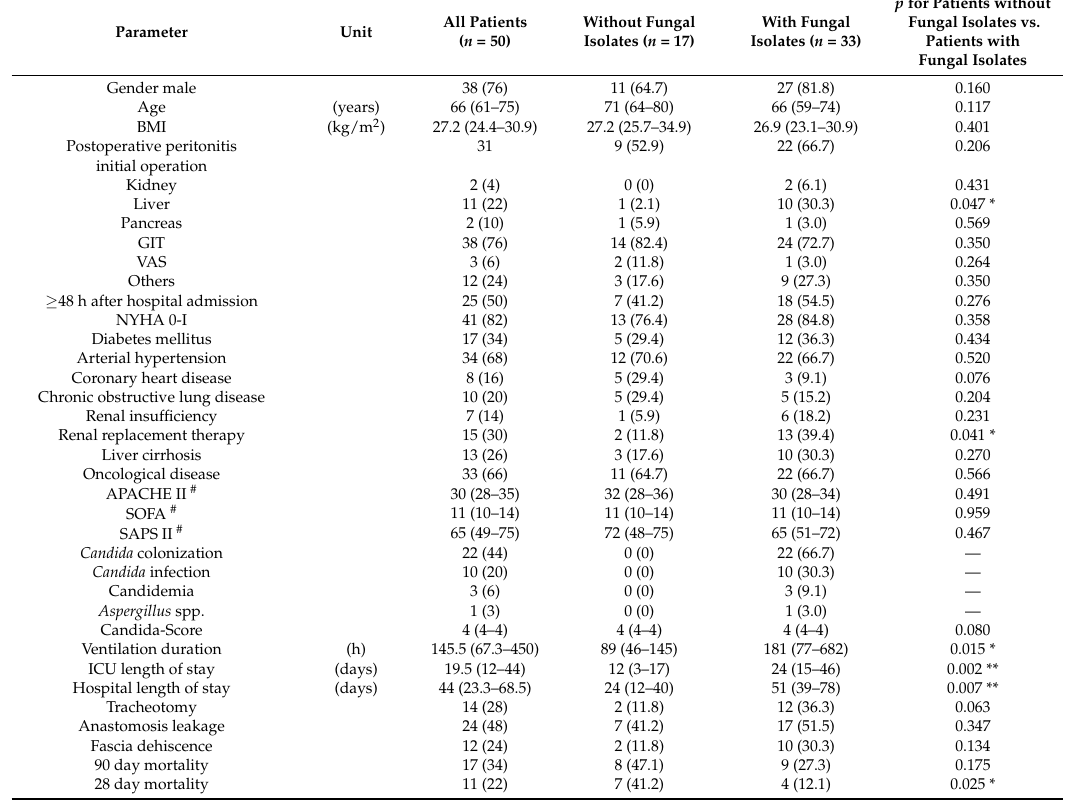
Table 1. Patient’s characteristics ( n =